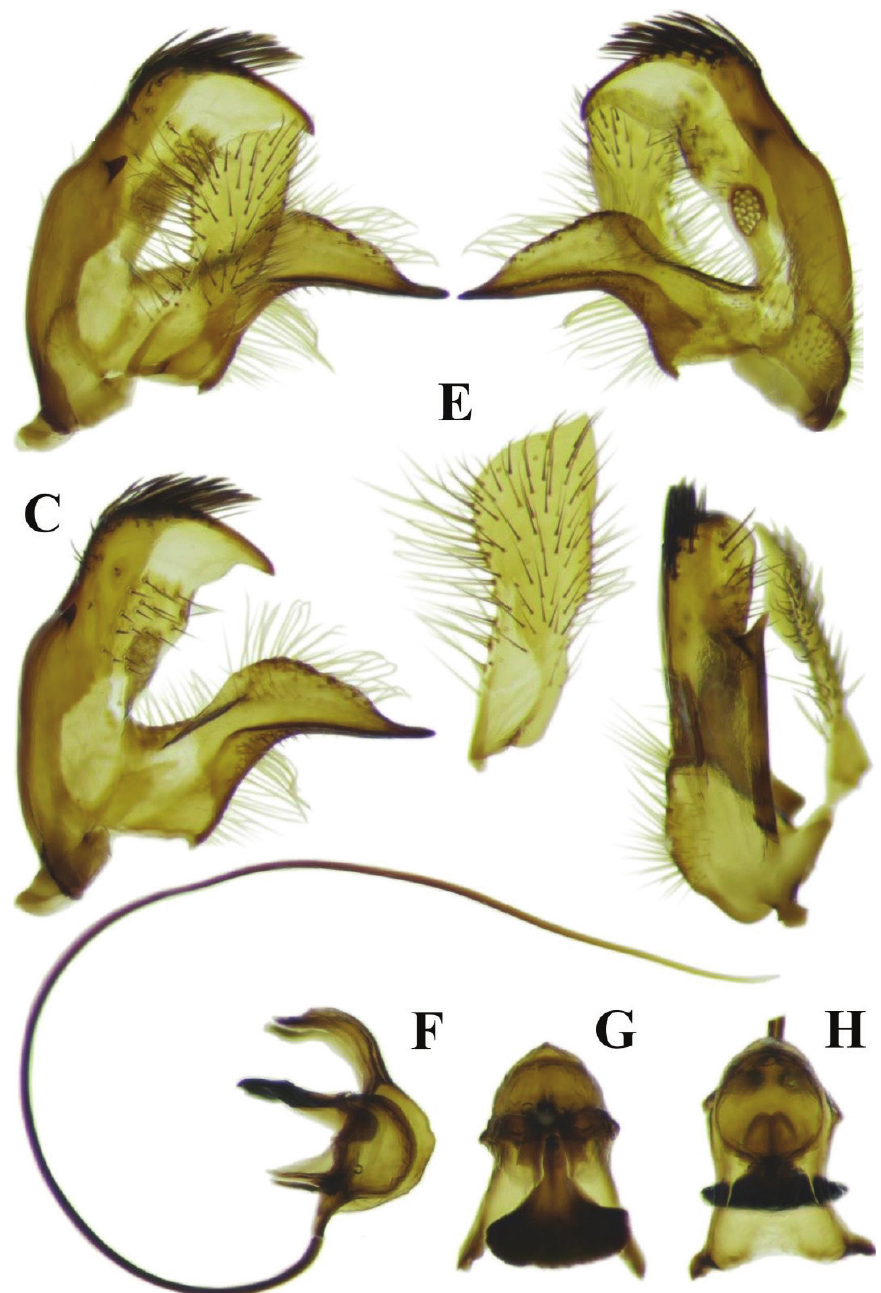
Figure 3. Photographs of the morphological structures of the male terminalia of the Tipula (Mediotipula) gjipeensis sp. n. A gonostyli outer-lateral view B gonostyli inner-lateral view C inner gonostylus outer- lateral view D gonostyli ventral view E inner gonostylus outer lateral view F aedeagus complex lateral view G sperm pump ventral view H sperm pump distal